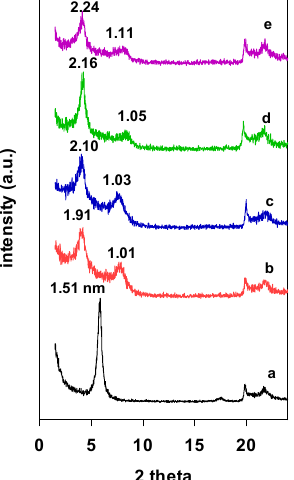
Figure 1. PXRD patterns of Zr intercalated clays (Zr(X)-Mt) with different starting Zr/clay ratios. (a) 0, (b) 3, (c) 6, (d) 12, and (e) 24.